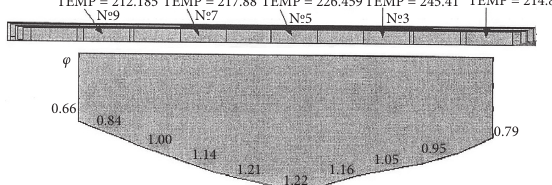
Figure 2: Temperature in material samples and a graph of the relative distribution of the neutron flux density ( φ , relative units) along the height of the irradiation device assembly.